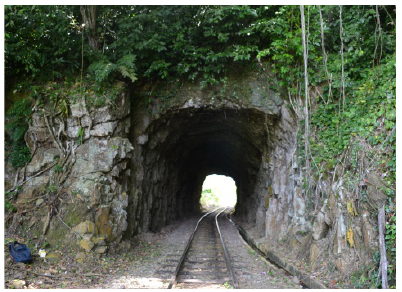
Figure 1a: Entrance of Tenom Tunnel. Photo direction – east southeast (ESE) to west northwest (WNW)